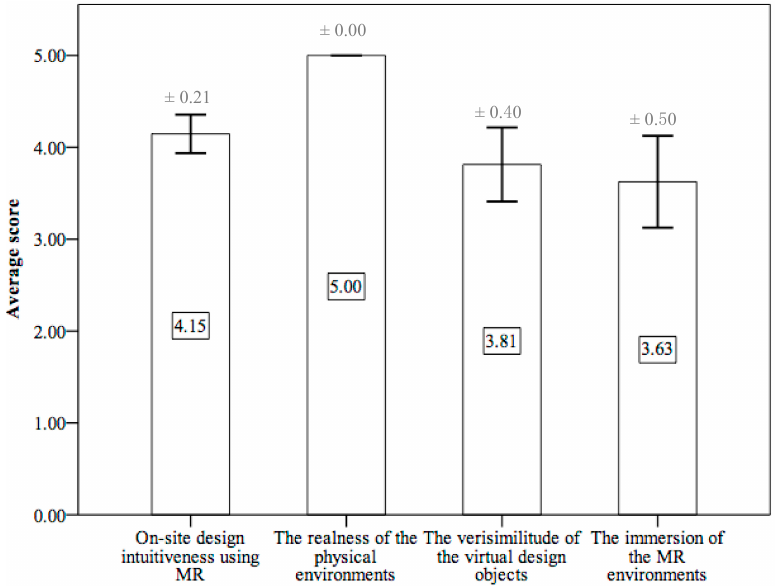
Figure 10. The mean and standard deviation of the score for on-site design intuitiveness using MR, the realness of the physical environments, the verisimilitude of the virtual design objects, and the immersion of the MR environments.